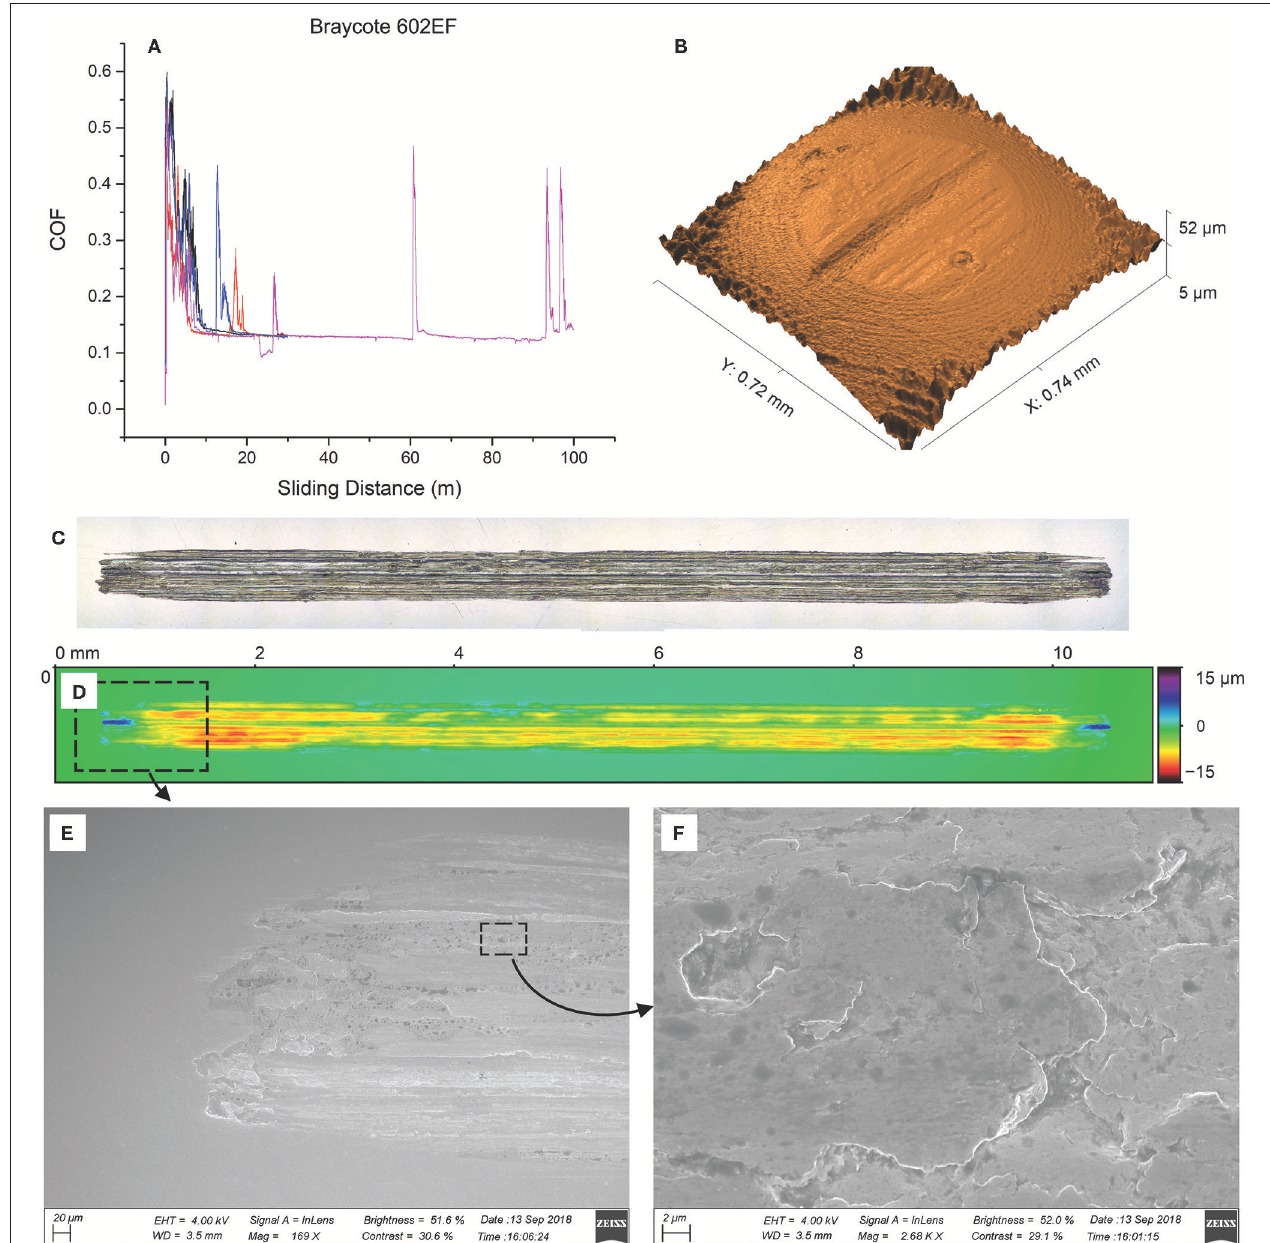
FIGURE 4 | Test results for Braycote 602EF including (A) friction traces, (B) interferometer image of the ball wear scar, (C,D) optical microscope and interferometer images of the flat wear scar, and (E,F) SEM micrographs of the flat wear scar. All wear images correspond to the test shown in blue in (A) .